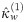
”Error-bar” plots of the Cohen’s kappa coefficient estimates (percent) for EXP1, P1 vs P2 ratings.The confidence intervals are at 95% confidence level and estimates corresponding to κ^w(1), κ^w(1) (DBR) and κ^w(1) (IR) are in red, green and blue, respectively.